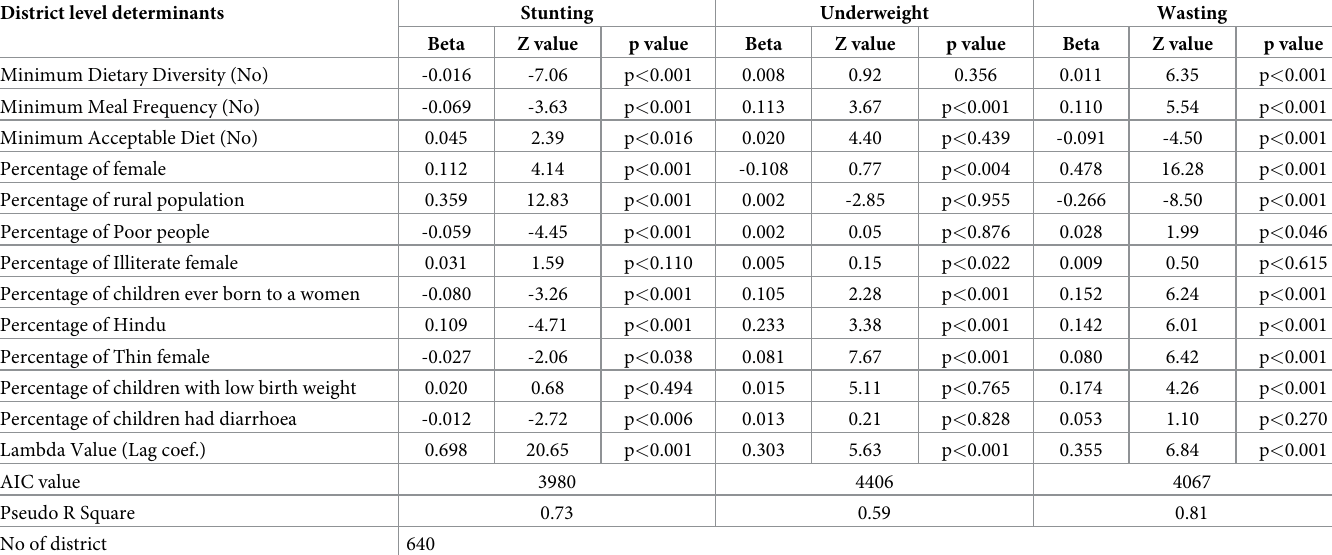
Table 5. Estimated results from the Spatial Error Model for stunting, underweight and wasting in districts of India, 2015–16. District level